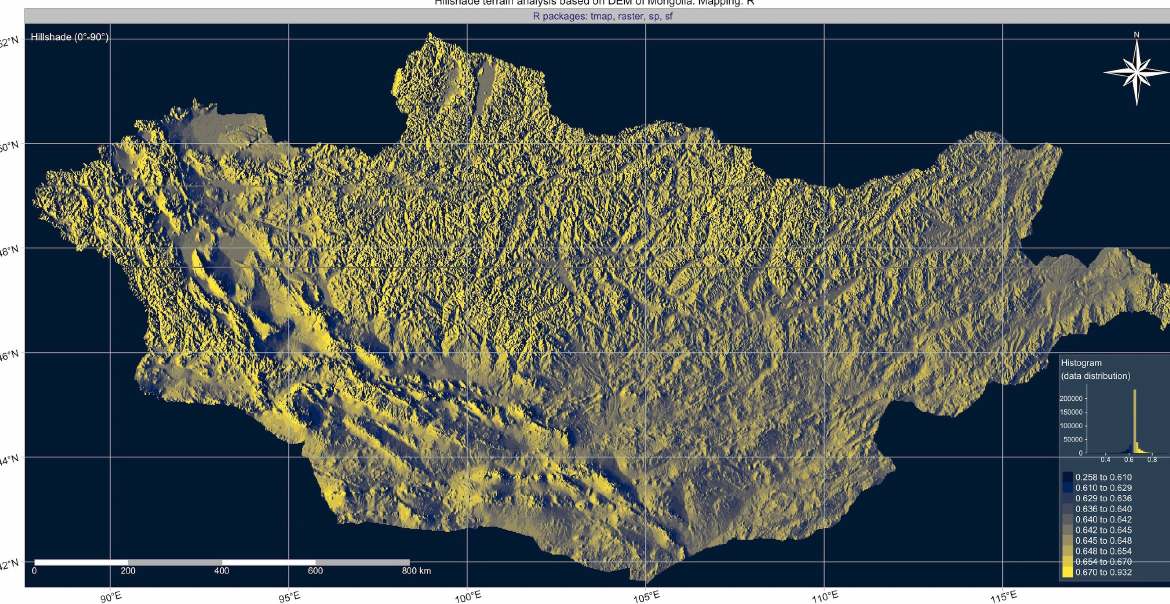
Fig. 9. Geomorphometric model of hillshade of Mongolia. Mapping: R. Source: